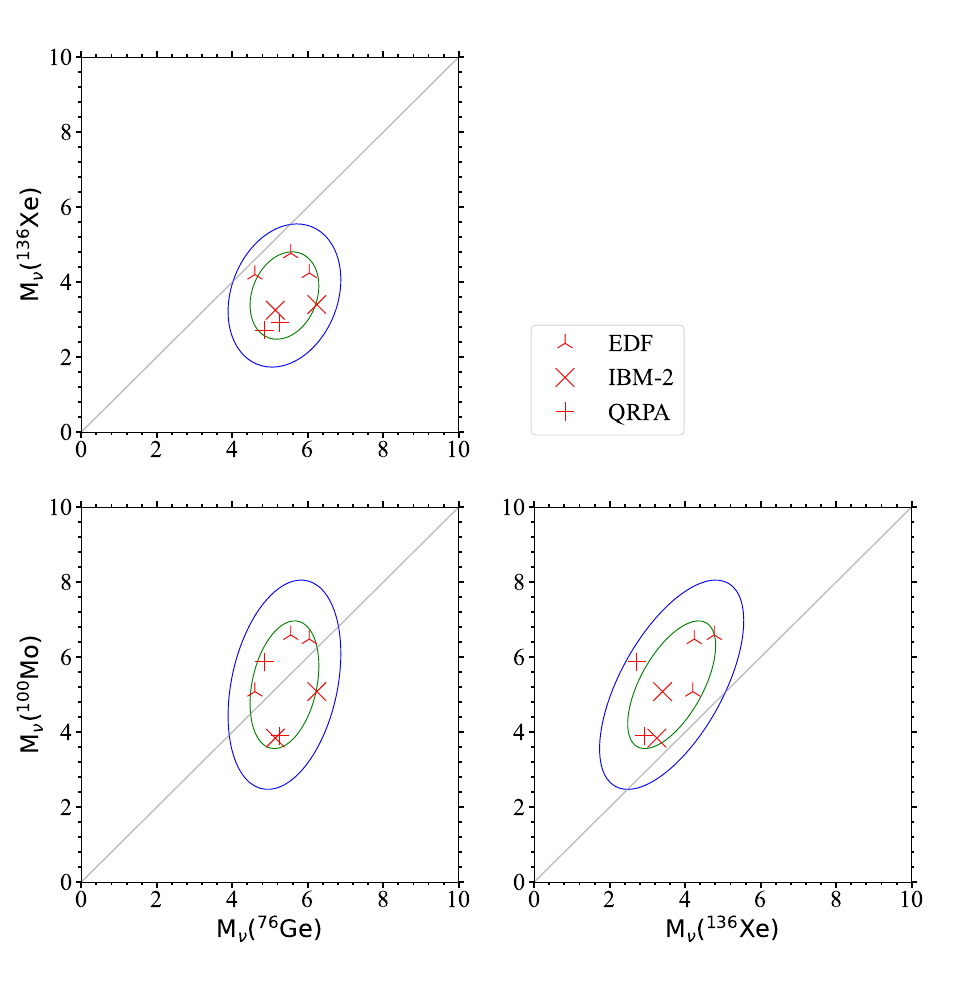
Figure 2 . NMEs reported by EDF [38, 39, 53], IBM-2 [15, 54] and QRPA [55, 56], with correlation ellipses corresponding to 1 and 2 σ confidence regions between isotope pairs of 76 Ge, 100 Mo, 136